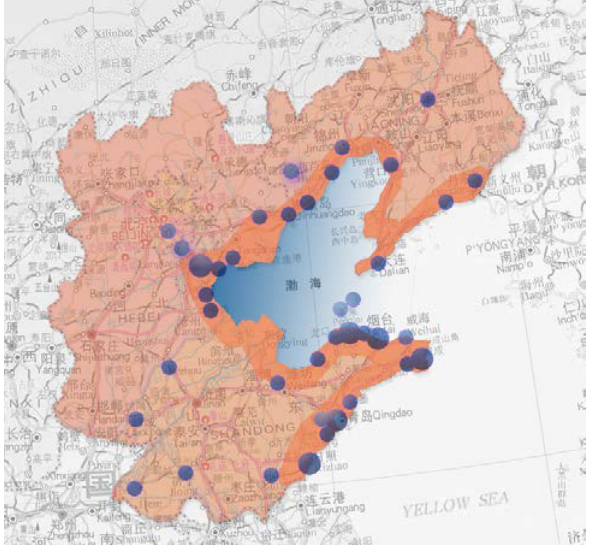
Figure 2. Distribution of Matsu Temple in Bohai